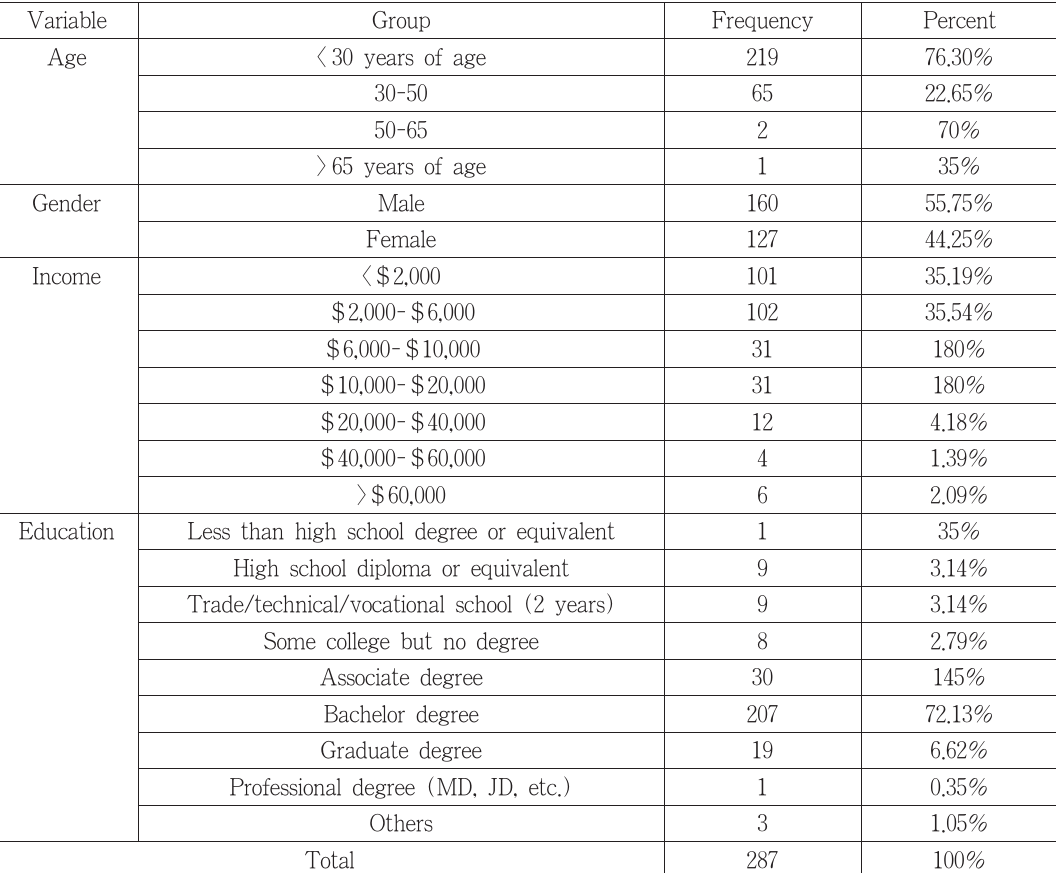
<Table 1> Respondents’ Socio-Demographic